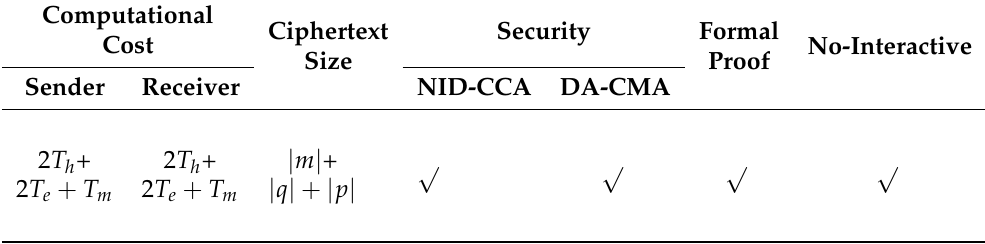
Table 1. Performance analysis.